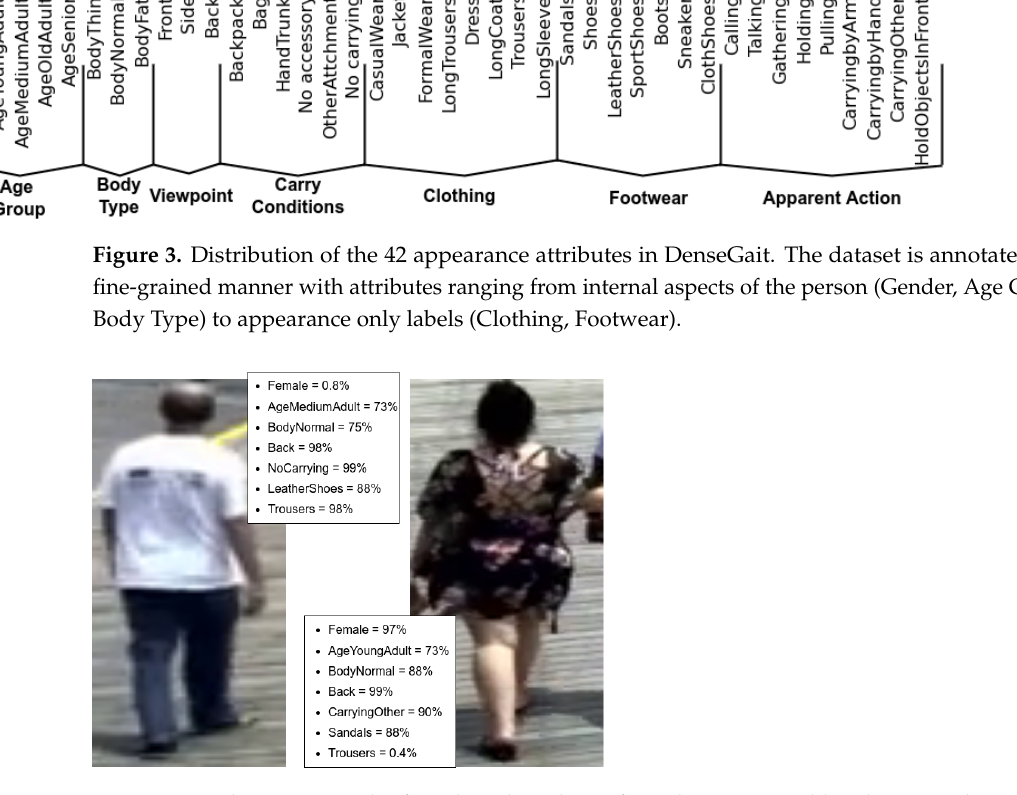
Figure 4. Qualitative examples for selected attributes from the PAI ensemble. The networks correctly identify gender, age group and viewpoint. However, in some cases, clothing and, more specifically, footwear are more difficult to estimate in low resolution